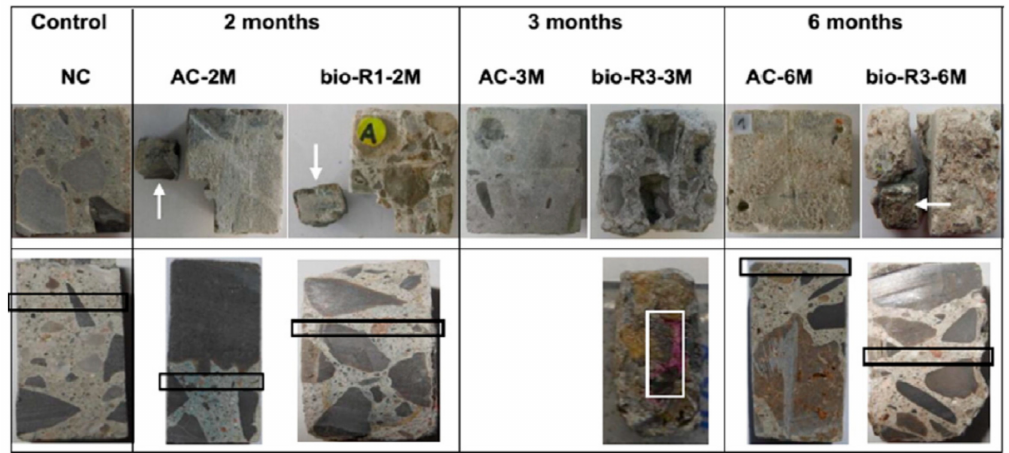
Figure 4. Impact of sulphuric acid attack on the durability of concrete specimens compared to the control [19]. “Reproduced with permission from Huber, B.; Hilbig, H.; Drewes, J.E.; Müller, E. Cem. Concr. Res; published by Elsevier,